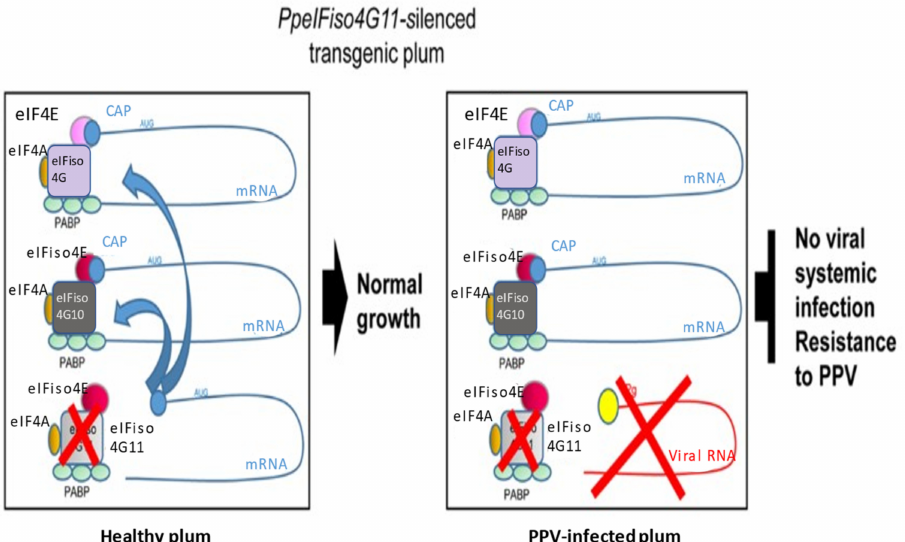
Figure 6. Model of eIFiso4F-mediated susceptibility to PPV in diploid plums from Rubio et al. [30]. The silencing of eIFiso4G, a translation initiation complex, prevents the development of the virus in the host but does not prevent the development of the plant. Translation initiation factors: eiF4E, eIFiso4E, eIFiso4G, eIFiso4G11, eIFiso4G10, and eIFiso4A; PABP: poly(A)-binding protein; CAP: catabolite activator